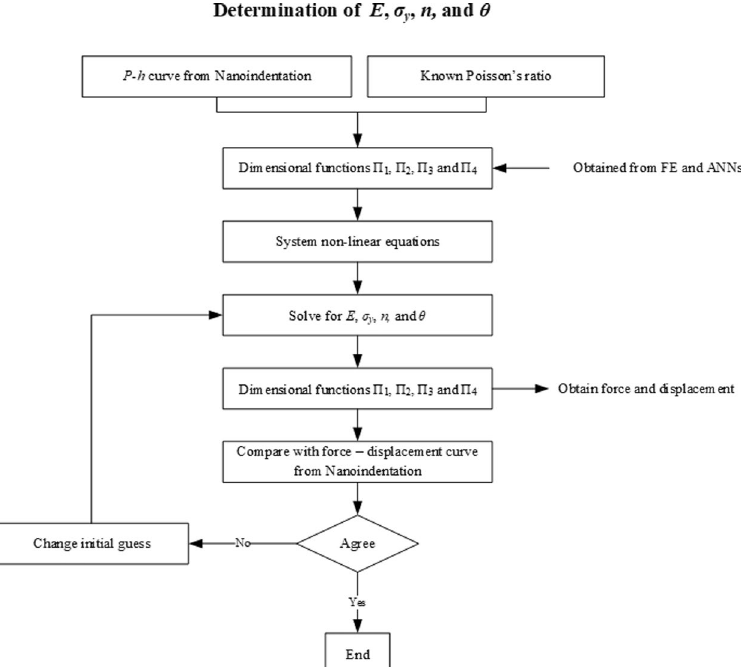
Figure 6. Flow chart: Inverse analysis algorithm.